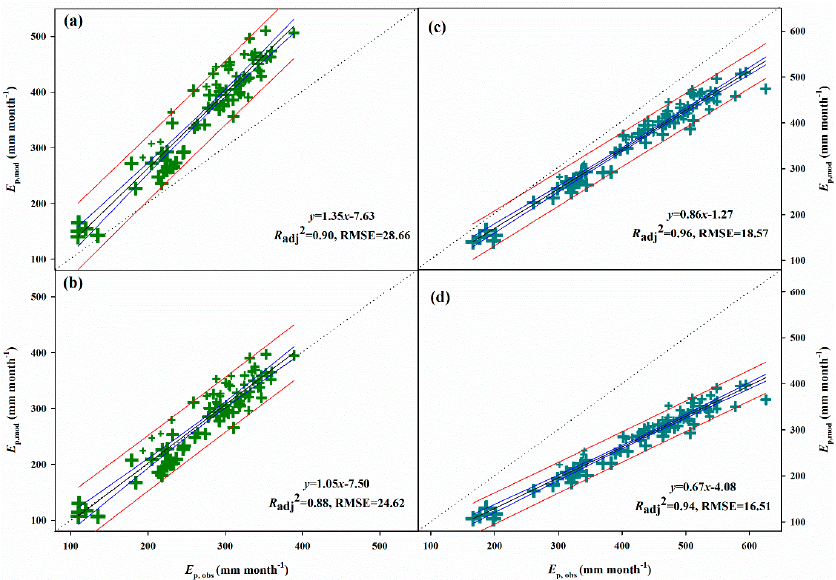
Figure 4. Relationship between monthly observed pan evaporation ( E p,obs ) by the E601 ( a , b ) and φ 20 ( c , d ) and calculated pan evaporation by the original ( a , c ) and modified ( b , d ) PenPan model ( E p,cal ) for Ejin station during the unfrozen period from 1986 to 2001. The symbol size represents the different month: maximum for October, minimum for April, and middle for the other months. The linear fitting, 95% confidence band, prediction band line, and value of regression analysis are shown.